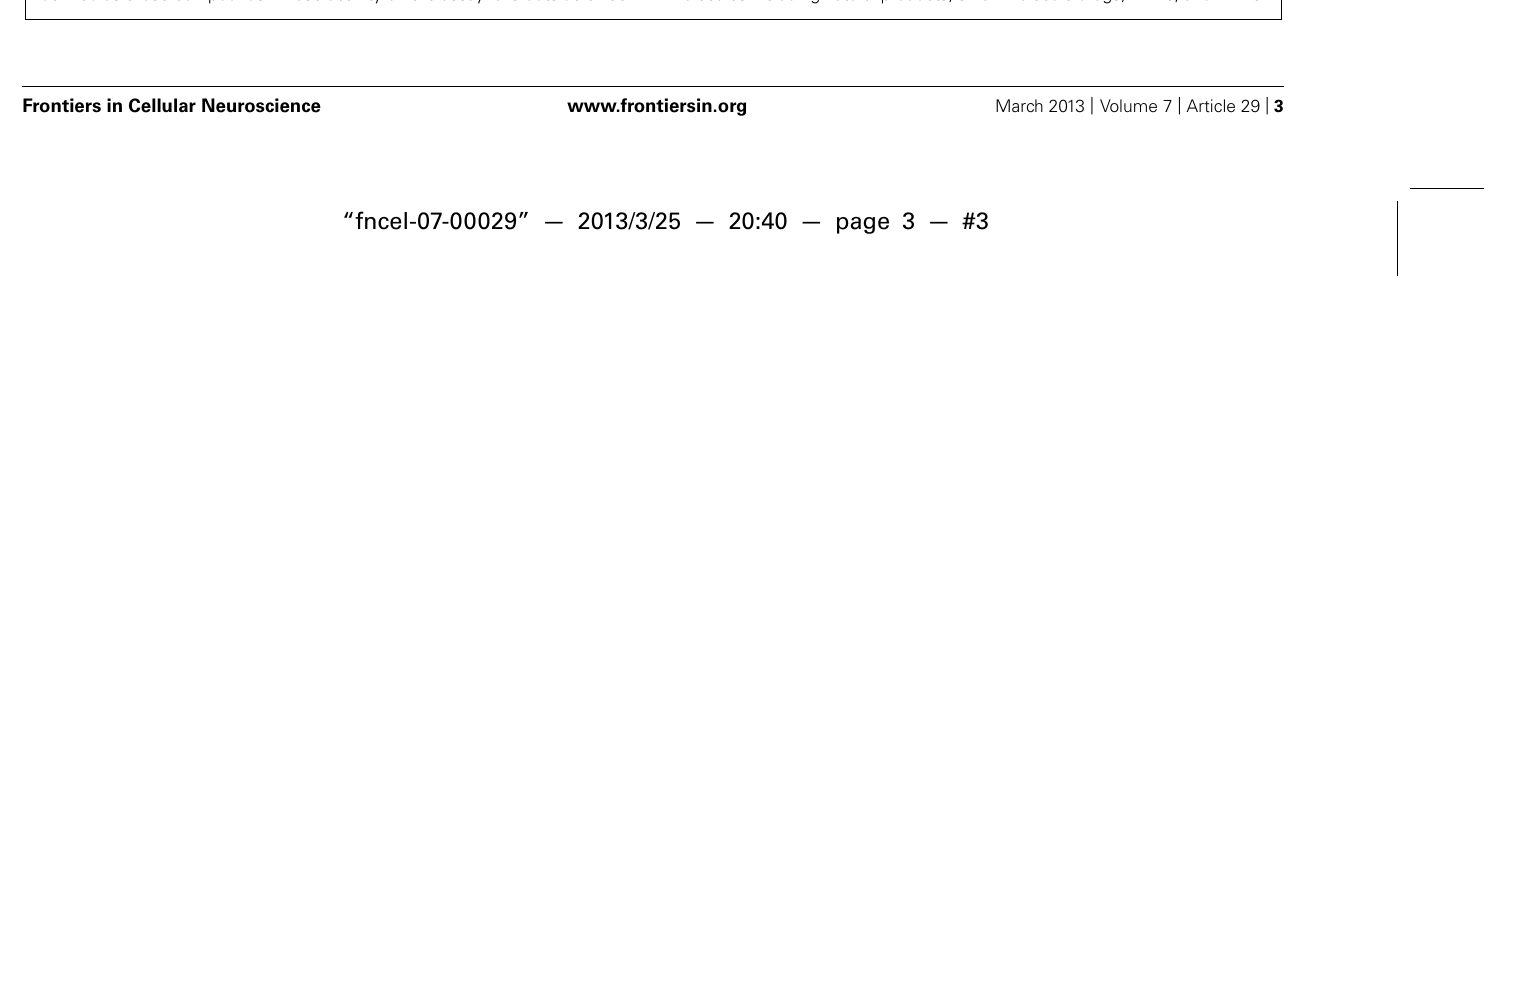
standard deviations (red lines) around the mean of the controls on the plate (blue dots). Hits are the gray dots above and below the red lines. Secondary screens are then used to validate the initial hits.These screens may include dose–response curves or assays of related functions of interest, resulting in a selection of “validated hits,” which may comprise fewer than 1% of a typical library of compounds of varied structure. Here the validated hits are the numbered dots above the red line.Validated hits are then further assayed and modified chemically in an iterative process to improve potency, selectivity, pharmacological properties, and toxicological profile to produce a drug lead compound that will go into “preclinical” testing in animal models. High throughput screening is applied to large libraries of any potentially bioactive molecules including natural products, small molecule drugs, RNAs, and